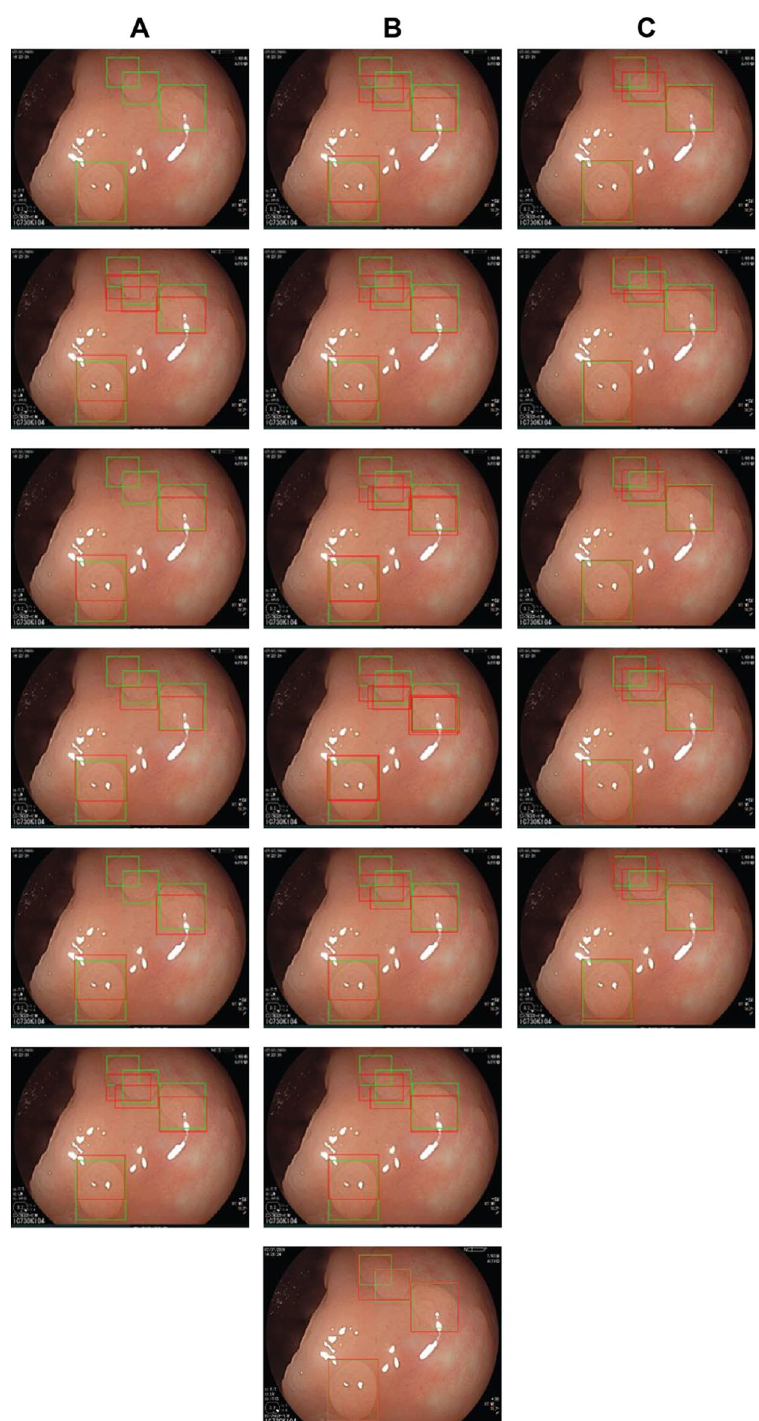
Figure 6. Predictions comparison sample. Column A displays, from the top to the bottom, the results of the following models: GT, Faster R-CNN, FCOS, RetinaNet, EfficientDet, and YOLOv5. Column B evaluates the predictions using ensemble techniques (NMS, NMW, SOFT-NMS, Soft Linear, WBF, and WBF Max) and Cascade R-CNN. The third column reports the results of our stacking technique using different meta-learner models: StackBox with Logistic Regression, StackBox with Adaboost, StackBox with Random Forest, StackBox with Gradient Boosting, and StackBox with XGBoost. The ground truth is represented by the green bounding boxes and the predictions by the red bounding